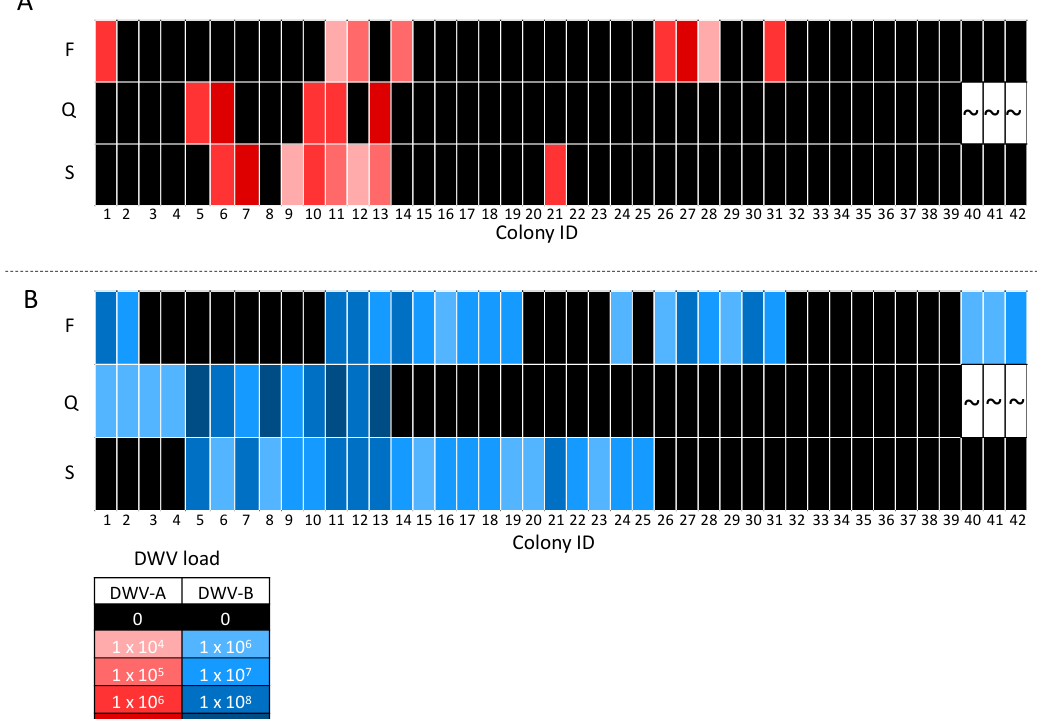
Figure 4. Heat map comparing DWV-A ( A ) and DWV-B ( B ) viral loads (genome equivalents) of queens and corresponding pooled worker bee samples from foster (F) and source (S) colony combinations. Colony IDs are displayed on the x axis, allowing queens to be identified by their corresponding foster and source colony. Viral loads are indicated by color intensity, whereby darker shades indicate higher viral load, black represents negative samples, and “~“ represents the three queens that died.